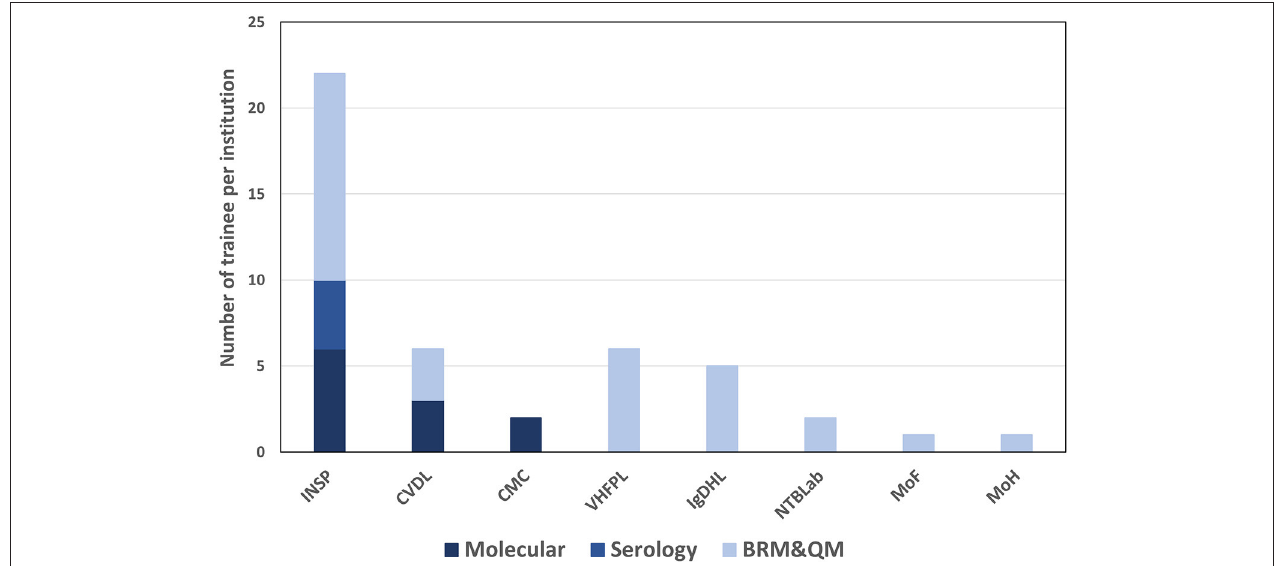
FIGURE 2 | Number of trainees per institution and per training topic. INSP, national institute of public health; CVDL, central veterinary diagnostic laboratory; CMC, medical communal center; VHFPL, viral hemorrhagic fever project laboratory; IgDHL, ignace deen hospital laboratory; NTBLab, national tuberculosis laboratory; MoF, ministry of fisheries; MoH, ministry of health; BRM & QM, biorisk management and quality